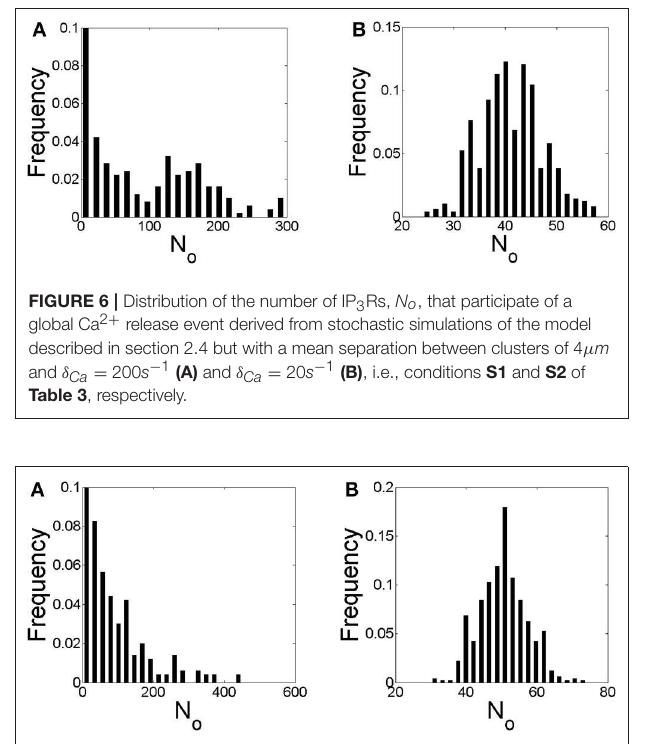
FIGURE 7 | Similar to Figure 6 but with a mean separation between clusters of 0.4 µ m and δ Ca 200 s − 1 (A) and δ Ca 20 s − 1 (B) , i.e., conditions S3 and = = S4 of Table 3 ,